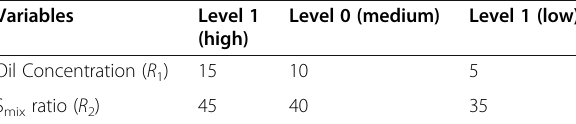
Table 6 Actual unit with coded labels (3 2 factorial designs) Variables Level 1